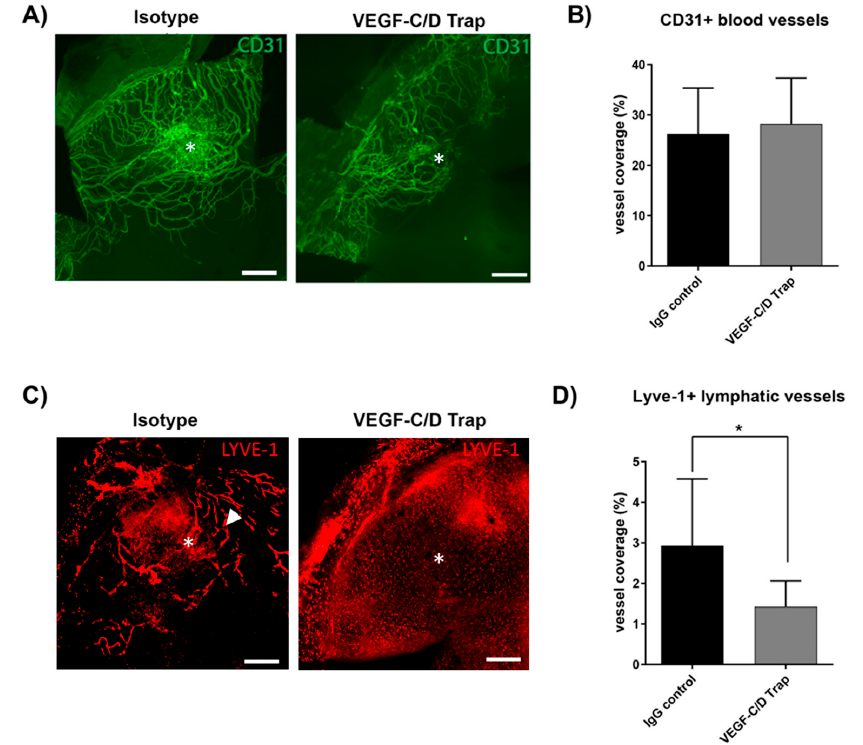
Figure 2. Specific inhibition of Lymphangiogenesis by VEGF-C / D blockade. ( A ) Representative examples of whole-mount corneas 14 days after suture placement stained for CD31 + vessels (green). Scale bar represents 500 µ m. Asterisks indicate the position of the suture. ( B ) Quantification of whole-mount staining of CD31 + blood vessels, p = ns, n = 10 per group. ( C ) Representatives of same corneas as in ( A ) with staining for Lyve-1 + vessels. Scale bar represents 500 µ m. Arrowhead indicate lymphatic vessels ( D ) Quantification of Lyve + 1 staining, for VEGF-C / D trap (n = 10; * p =